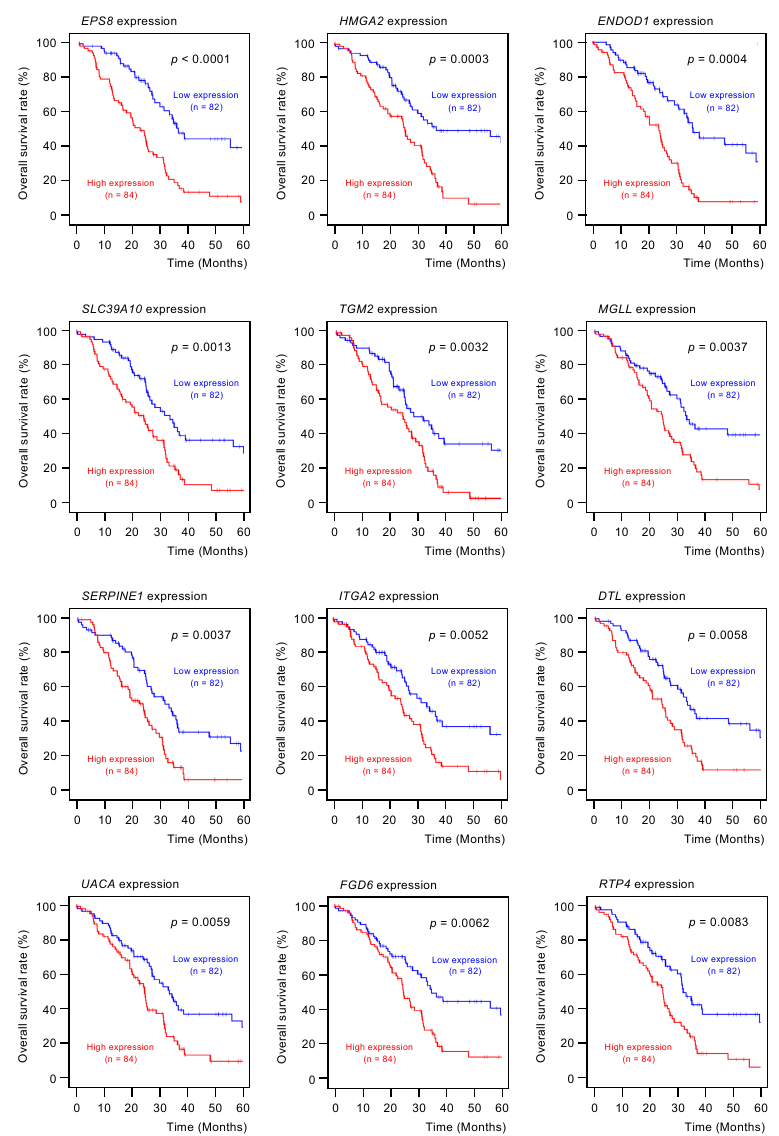
Figure 2. Clinical significance of the miR-30a-3p target genes by TCGA database analysis.